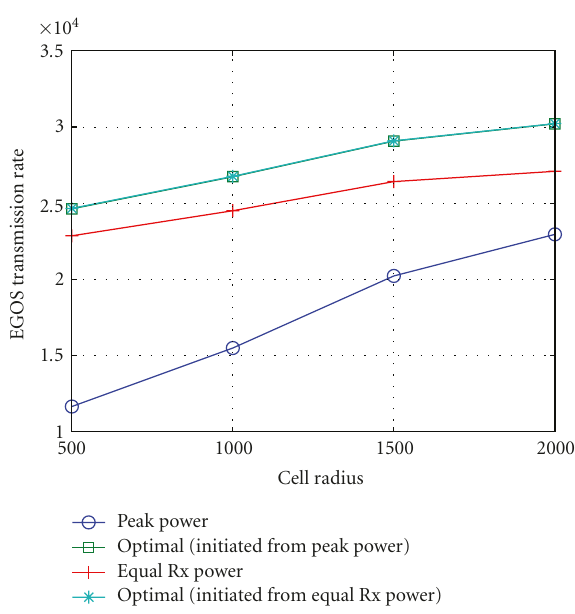
Figure 5: Asymptotic EGOS rates for di ff erent cell radiuses when w =